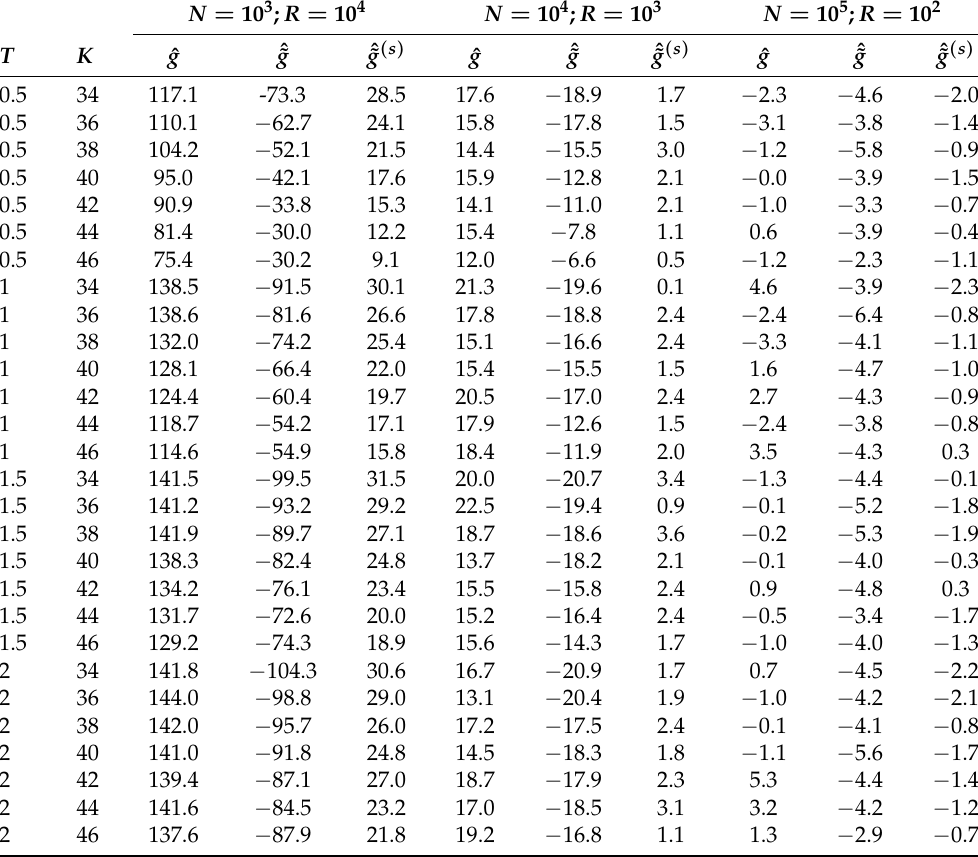
Table A1. Detailed bias results ( × 10 3 ) with optimized